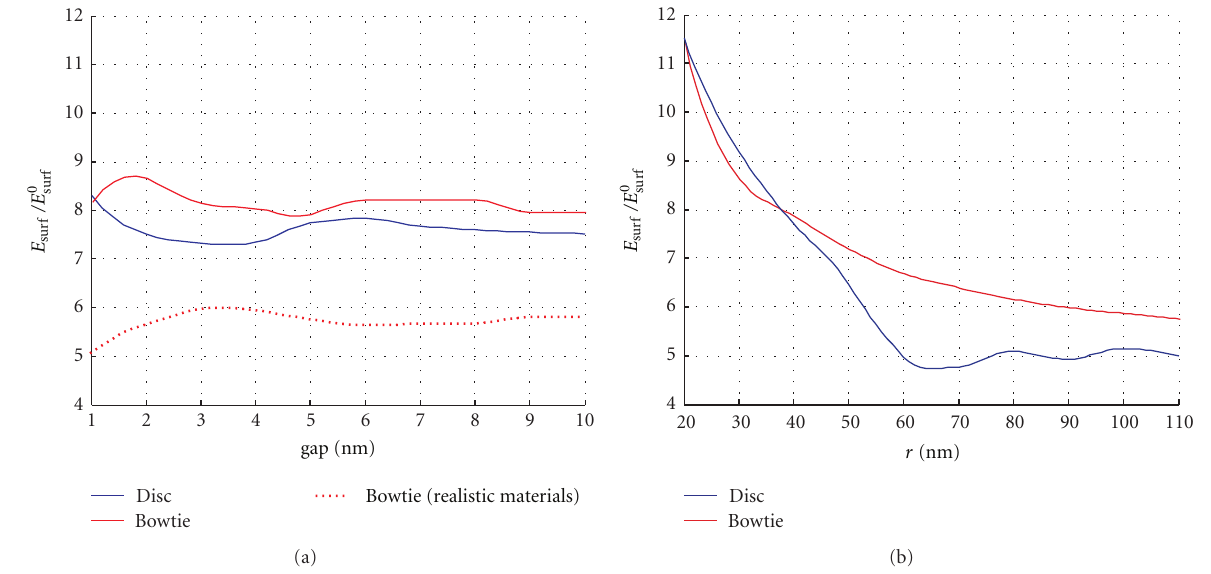
Figure 3: (a) Field enhancement for the disc dimer (blue line) and the bowtie (red line) on top of the Fabry-Perot structure as a function of the gap distance for a radius r = 40nm. The e ff ect of realistic lossy materials is also shown (red dotted line) for the bowtie configuration. (b) Field enhancement as a function of the radius r when gap = 5nm. For both panels, the dimer and the bowtie are both oriented along the dipole source (see Figure 1).